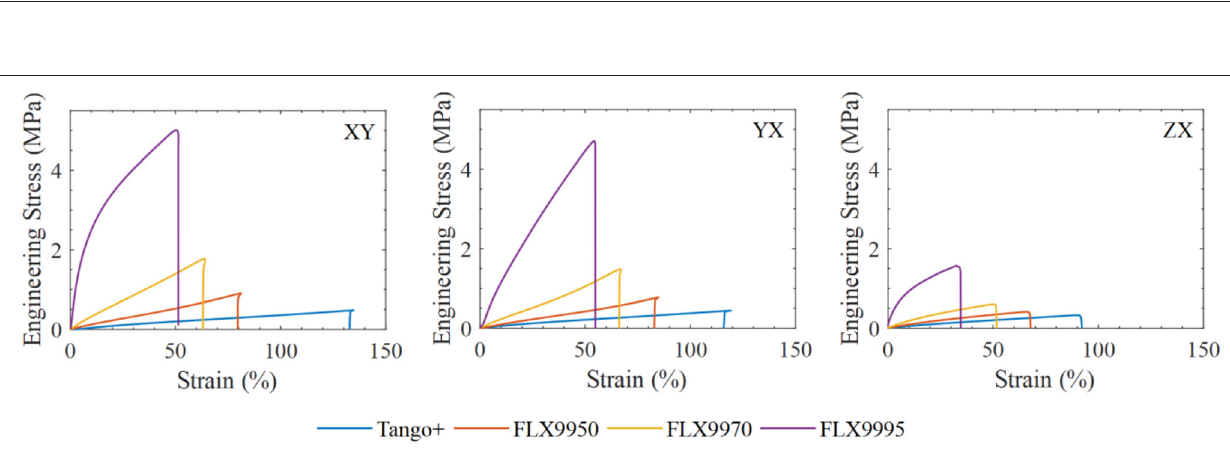
Frontiers in Physics |